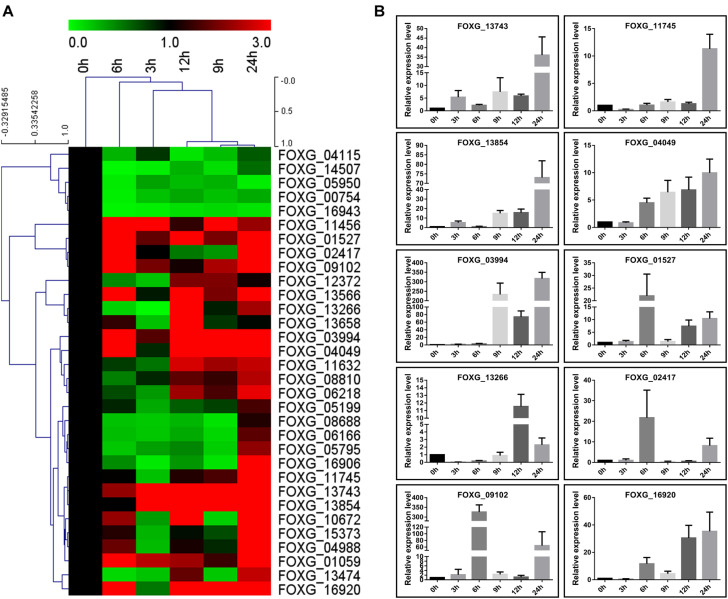
Transcription expression of 32 Kac proteins by qRT-PCR. (A) Hierarchical cluster of Kac proteins in transcript abundance with different development stages of conidia (0, 3, 6, 9, 12, and 24 h) induced in liquid YEPD medium with tomato root. Each gene is represented by a single row of colored boxes, and a single column represents different times during development. Induction (or repression) ranges from black to saturated red (or green) with a fold change scale bar shown up the clusters. (B) Quantitative RT-PCR validation of 10 high up-regulated genes (fold change > 10). Histone 4 gene was used as internal control. The expression level means fold-changed obtained by quantitative RT-PCR (n = 3).